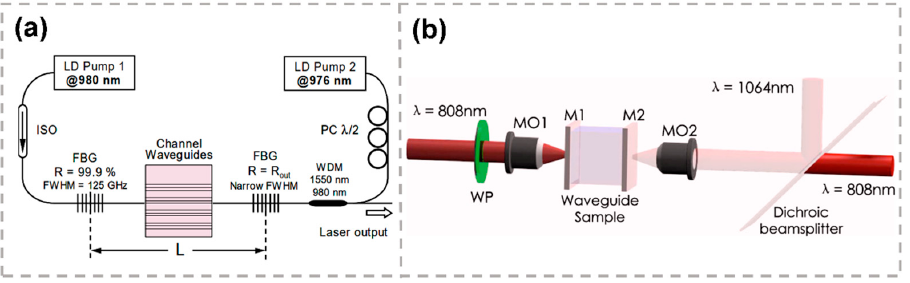
Figure 3. ( a ) The setup of waveguide linear laser cavity with a bi-directional pumping scheme adopted [48]. ( b ) Schematic of the experimental setup for the waveguide laser generation. WP: wave plate; MO1 and MO2: microscope objective lens; M1 and M2: laser cavity mirrors adhered to the two end-facets of the sample [68]. Reproduced from [48] with permission of the Optica Publishing Group. Reproduced from [68] with permission of the AIP Publishing, 2022.